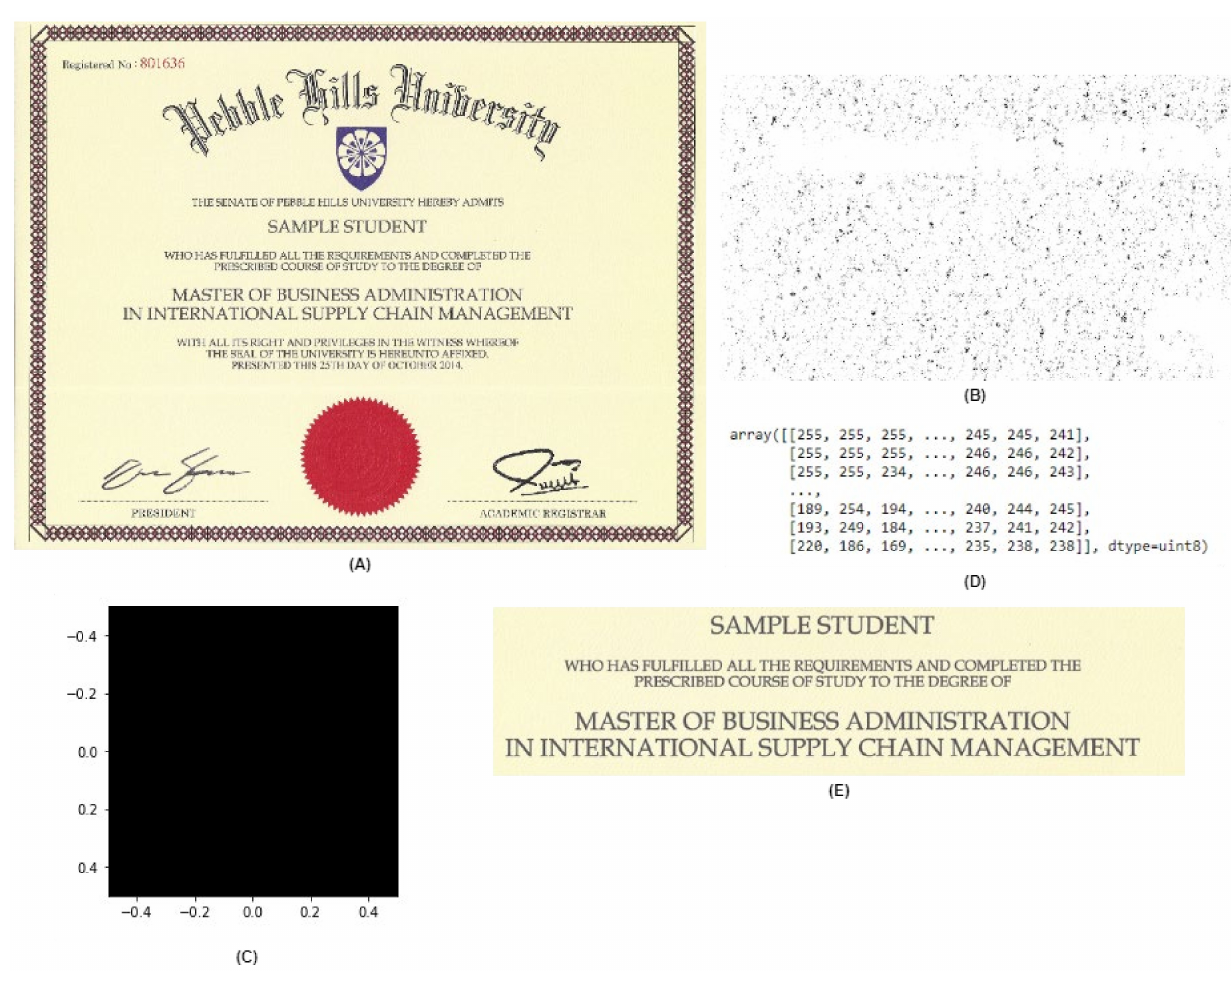
Figure 8. Another simulation result of the proposed accreditation model. ( A ) Input image, ( B ) encode to identify tampering, ( C ) convert into grayscale to fine trace, ( D ) image matrix, and ( E ) output to check individual